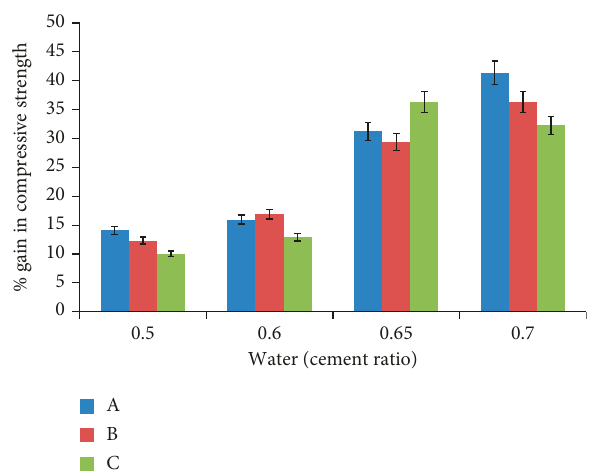
Figure 5: Percent gain in compressive strength after exposure to SW.